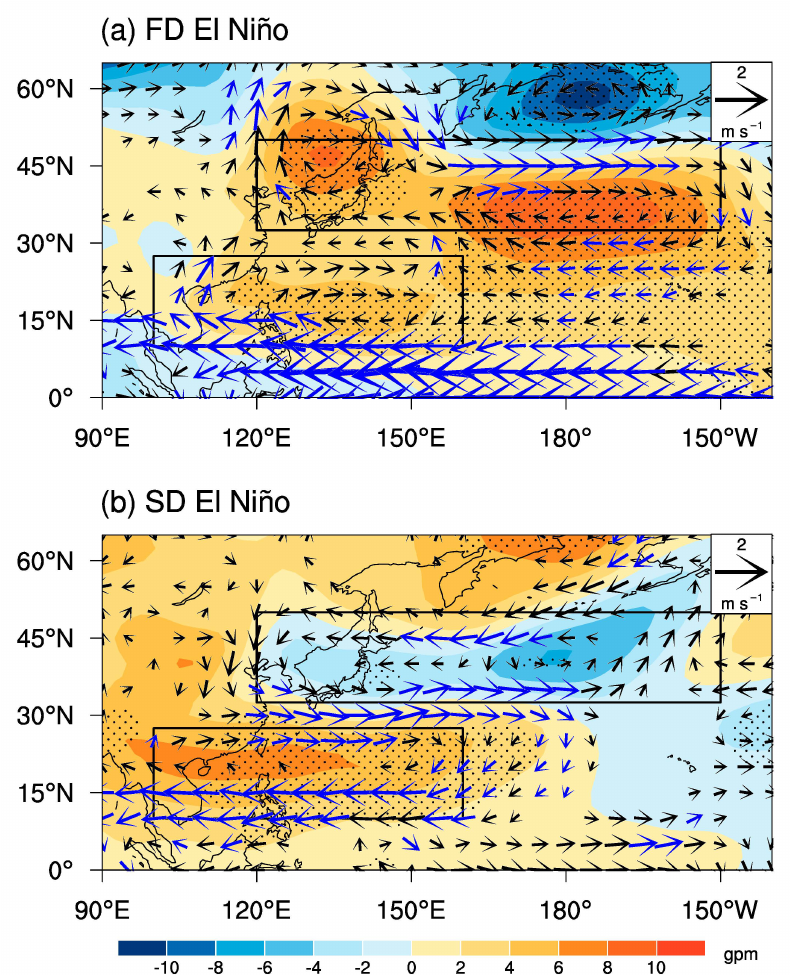
Figure 2. Composite 850 hPa geopotential height anomalies (shading) and wind anomalies (vectors) in ( a ) FD El Niño summers and ( b ) SD El Niño summers. Black dots and blue arrows indicate where the significance exceeds the 90% confidence